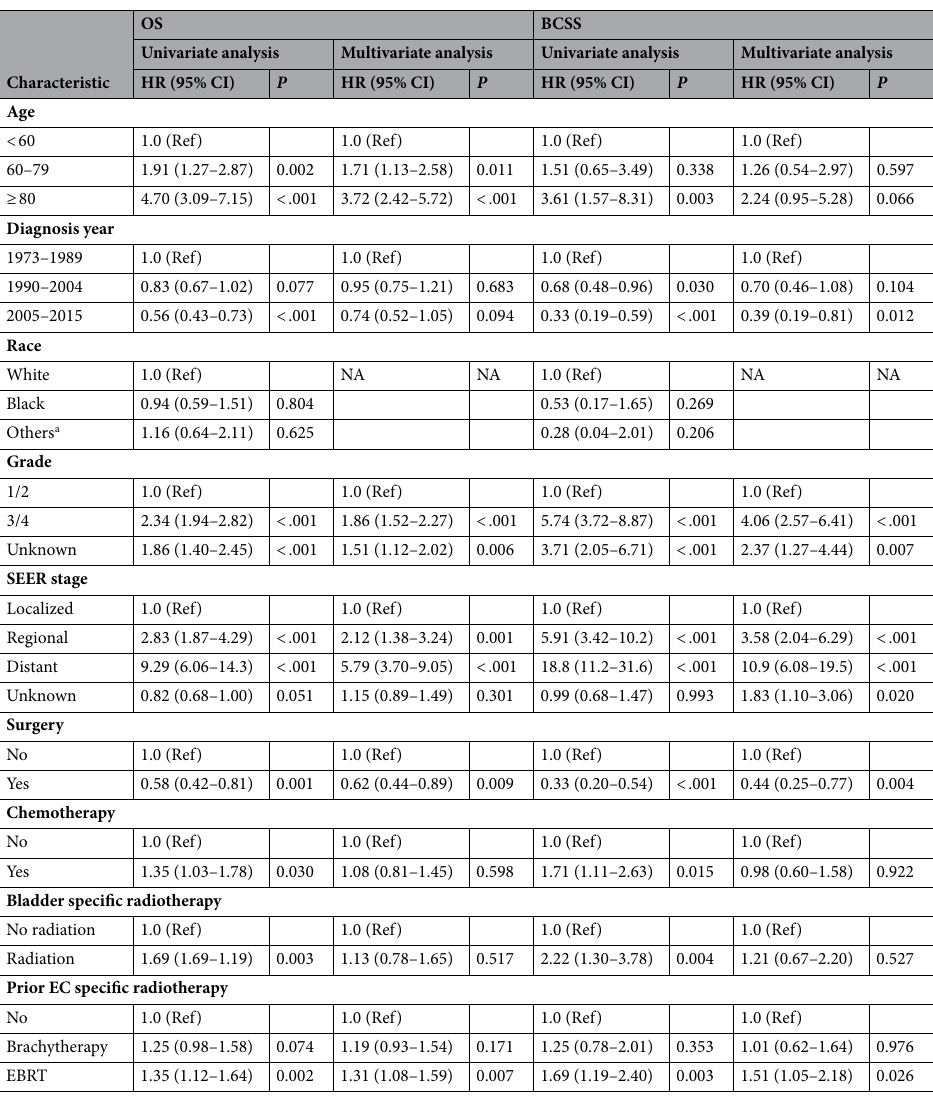
Table 4. Univariate and multivariate analysis for OS and BCSS of EC survivors who had SBC. HR, hazard ratio; Ref, reference category; CI, confidence interval; EBRT, external-beam radiotherapy; OS, overall survival; BCSS, bladder cancer-specific survival; SBC, secondary bladder cancer; EC, endometrial cancer. a Others including Asian and American